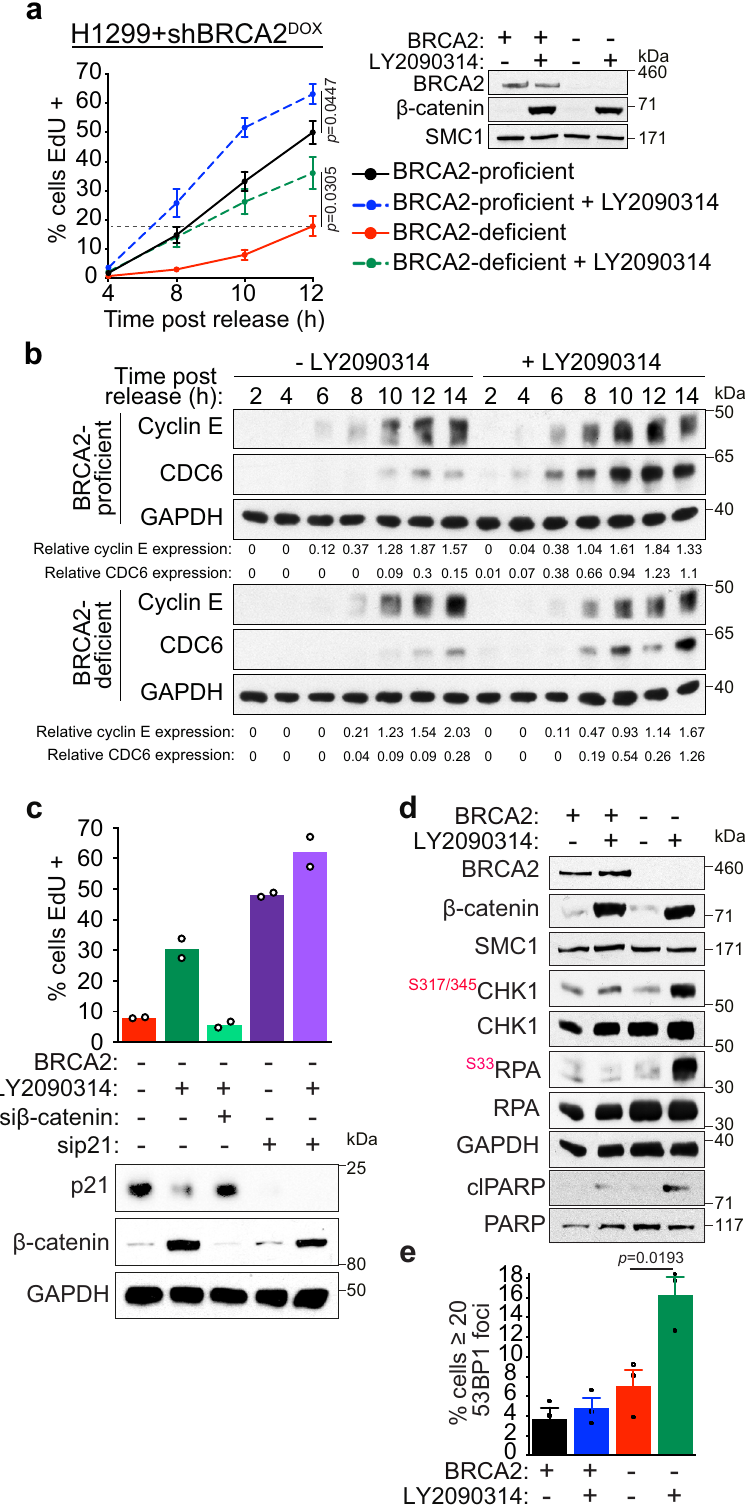
percentage of intragenic origins was ∼ 37%. This was similar to the 41% of intragenic origins triggered by cyclin E over- expression in U2OS cells 16 . Moreover, β -catenin-induced intragenic origin fi ring was dependent of gene size, with longer genes being more susceptible to illegitimate replication initiation events (Fig.